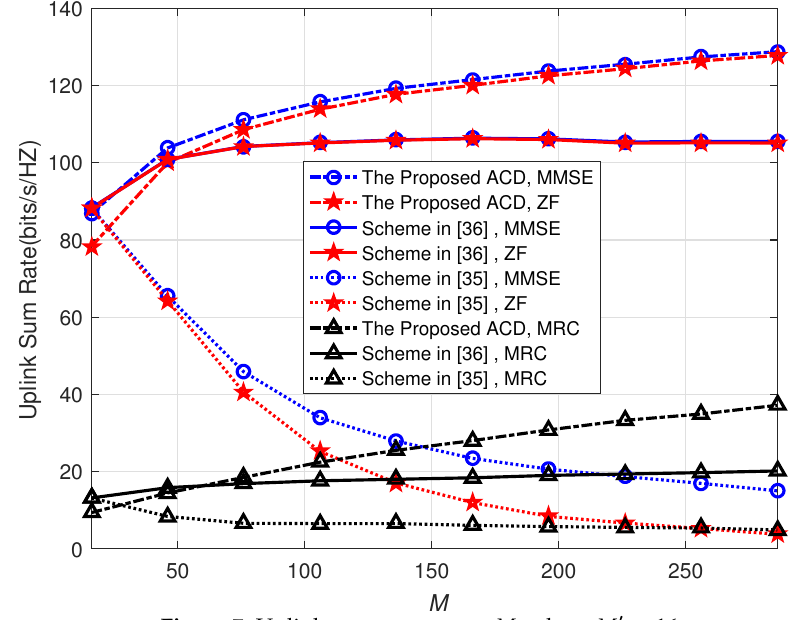
Figure 7. Uplink sum rate versus M , where M (cid:48) =